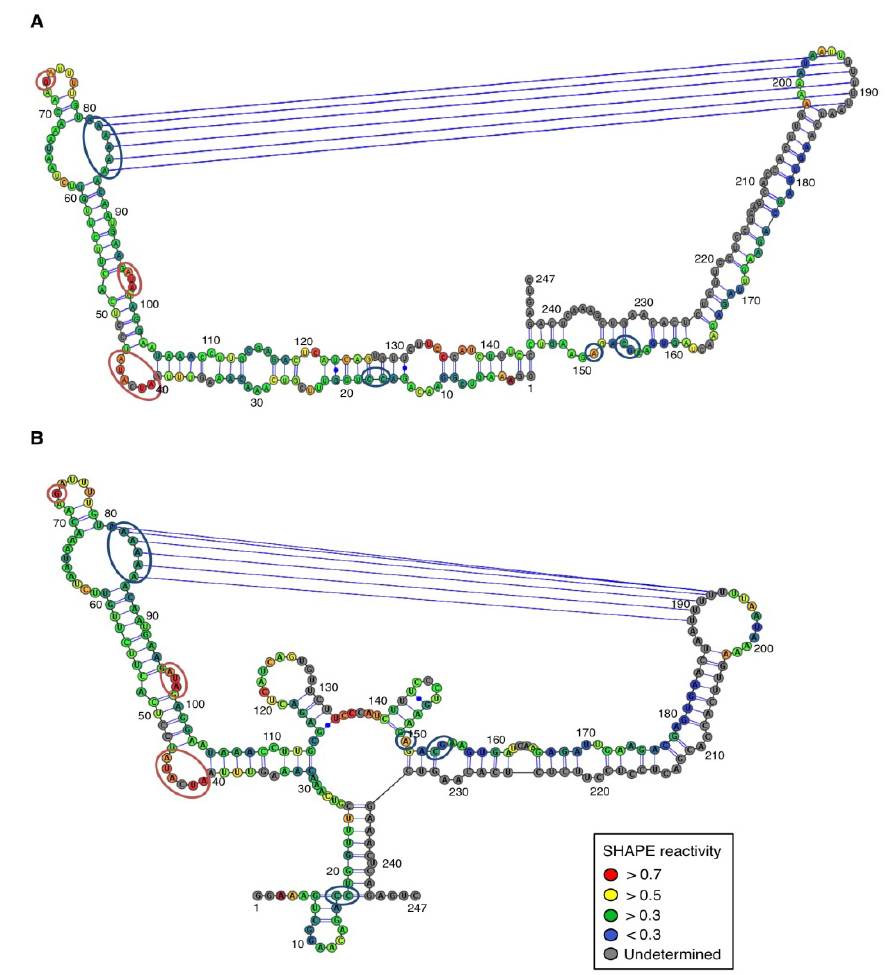
Figure 5. Secondary structure models of ASBVd ( − ) based on the SHAPE analysis. ( A ) and ( B ) are the two secondary structure models proposed for ASBVd ( − ). The color of the circle surrounding each nucleotide reveals their relative reactivity to 1M7 in the presence of 10 mM Mg 2+ , as mentioned in the box. High reactivity reflects single-stranded region, while paired nucleotides are not reactive. Nucleotides for which the reactivity could not be determined are shown in grey and correspond to the primer binding site, or to nucleotide right 3' to the primer for which the electrophoresis resolution is not good enough, or to RT stops. The same experiments were carried out without Mg 2+ and differences in reactivity are represented on the scheme: nucleotides circled in red show enhanced reactivity in the presence of Mg 2+ , and those in blue are less reactive. Blue lines represent the potential kissing-loop interaction. The models were designed using VaRNA